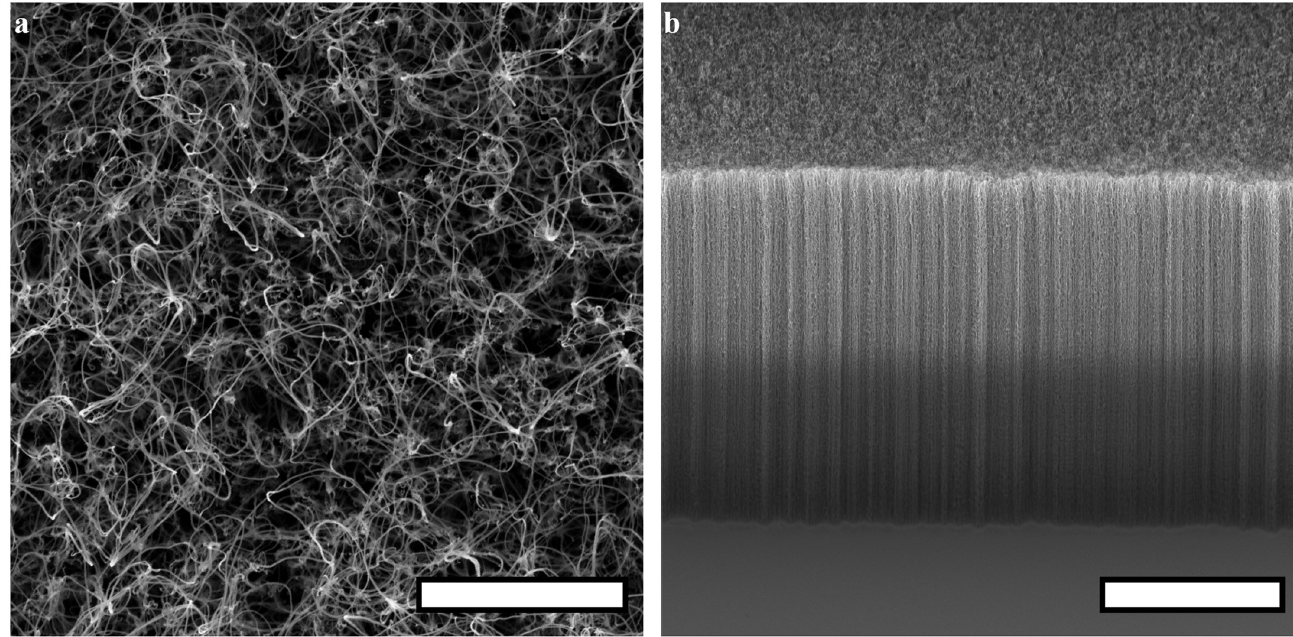
Fig 11. SEM images of patterned VACNT forests taken before the culturing experiments. (a) Top-down view of entangled VACNTs on the forest’s top surface, (b) View of the sidewall of a VACNT row taken at a 40˚ angle. Scale bars are 2 and 10 μ m,